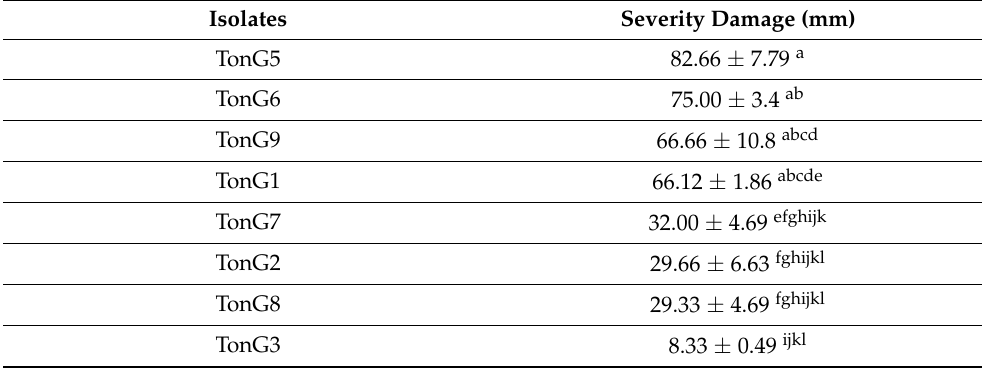
Figure 2. Fruit damage by the fungi. ( A ) Fusarium sp., ( B ) Colletotrichum sp., ( C ) Gliocladium sp., ( D ) Lasiodiplodia sp., and ( E ) Rhizopus sp. Table 1. Severity damage produced by isolated fungi on the soursop